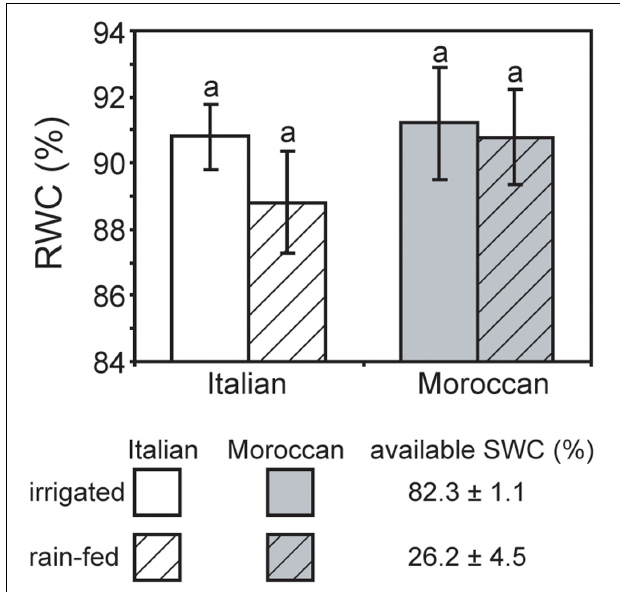
FIGURE 2 | Relative water content of leaves of Moroccan (gray) and Italian (white) Arundo donax ecotypes grown in the field under irrigated control (open) and rain-fed drought (hatched) conditions. Error bars indicate one standard error either side of the mean ( n = 6). Letters indicate homogenous groups determined using a one-way ANOVA and LSD post hoc test.